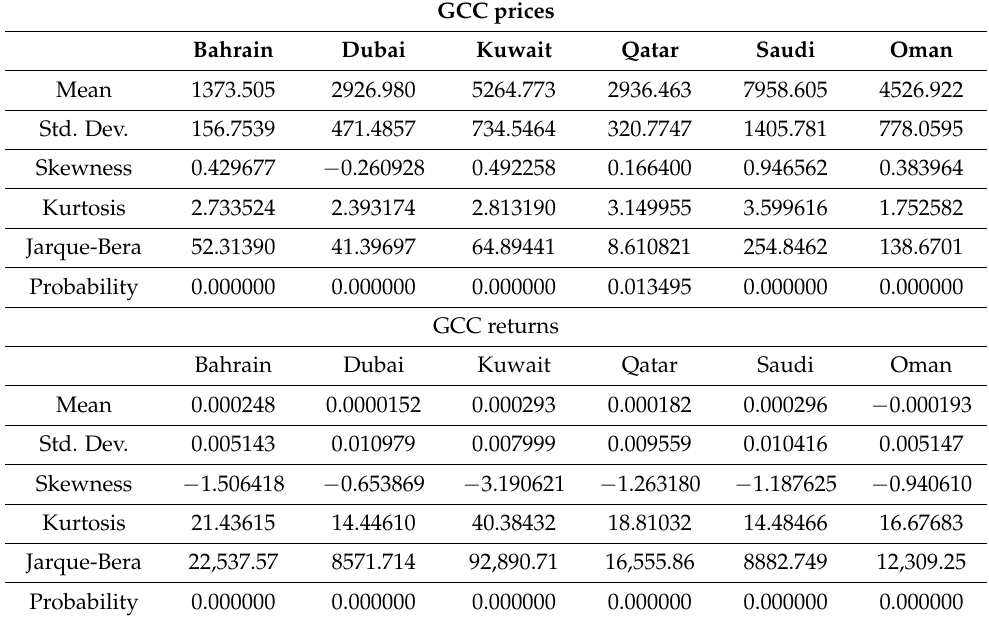
Table 3. GCC Descriptive Statistics.